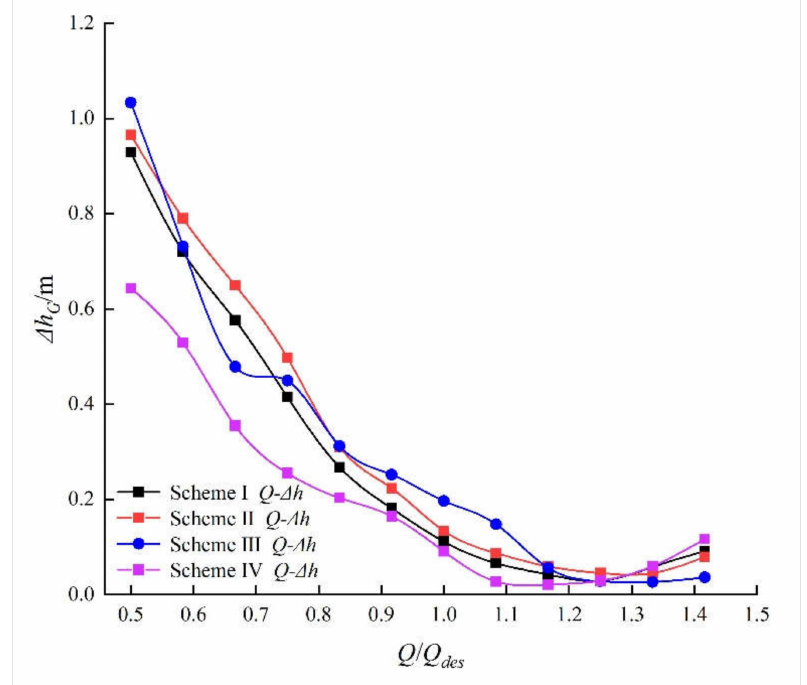
Figure 17. Hydraulic loss curves of guide vanes in different schemes.